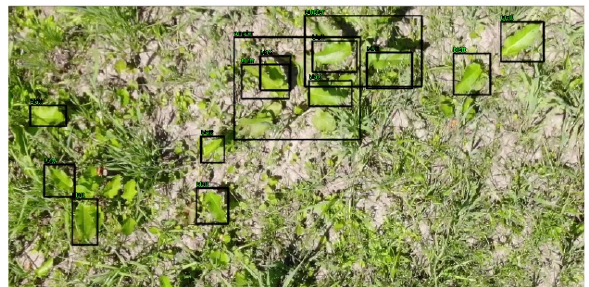
Eng. Proc. 2022 , 27 , 87 Figure 1. Annotation sample one. Black boxes are annotated R. obtusifolius plants.